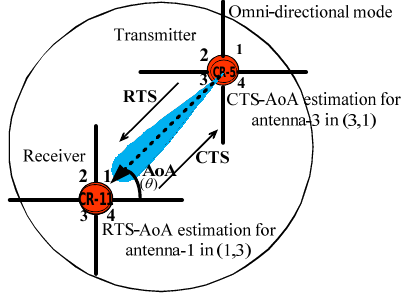
Figure 5. AoA estimation for directional DCF